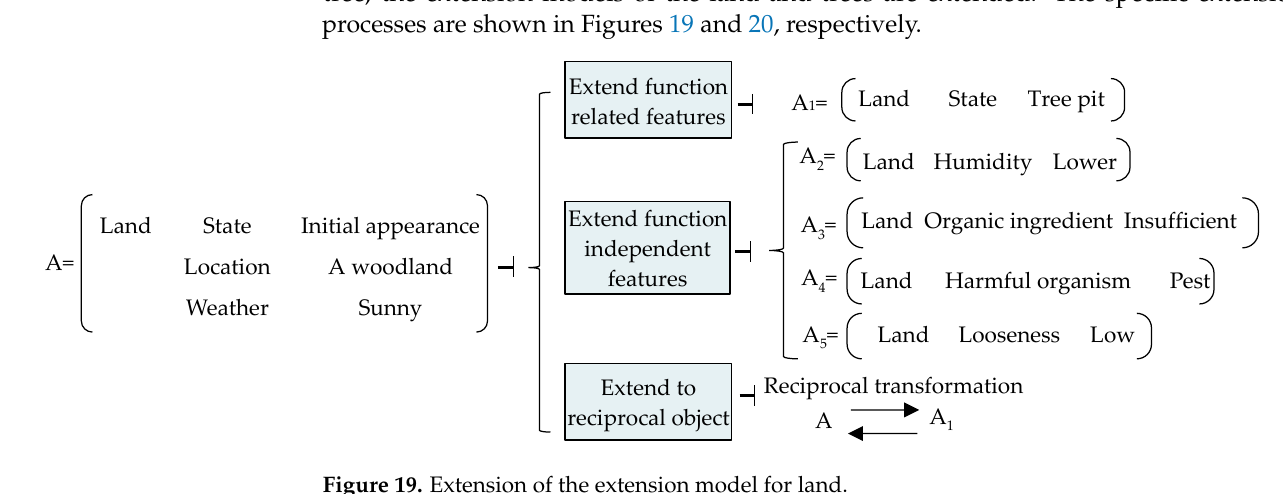
Figure 18. Initial scenario: Workers operate tree-planting machine to dig tree pit in the woodland.